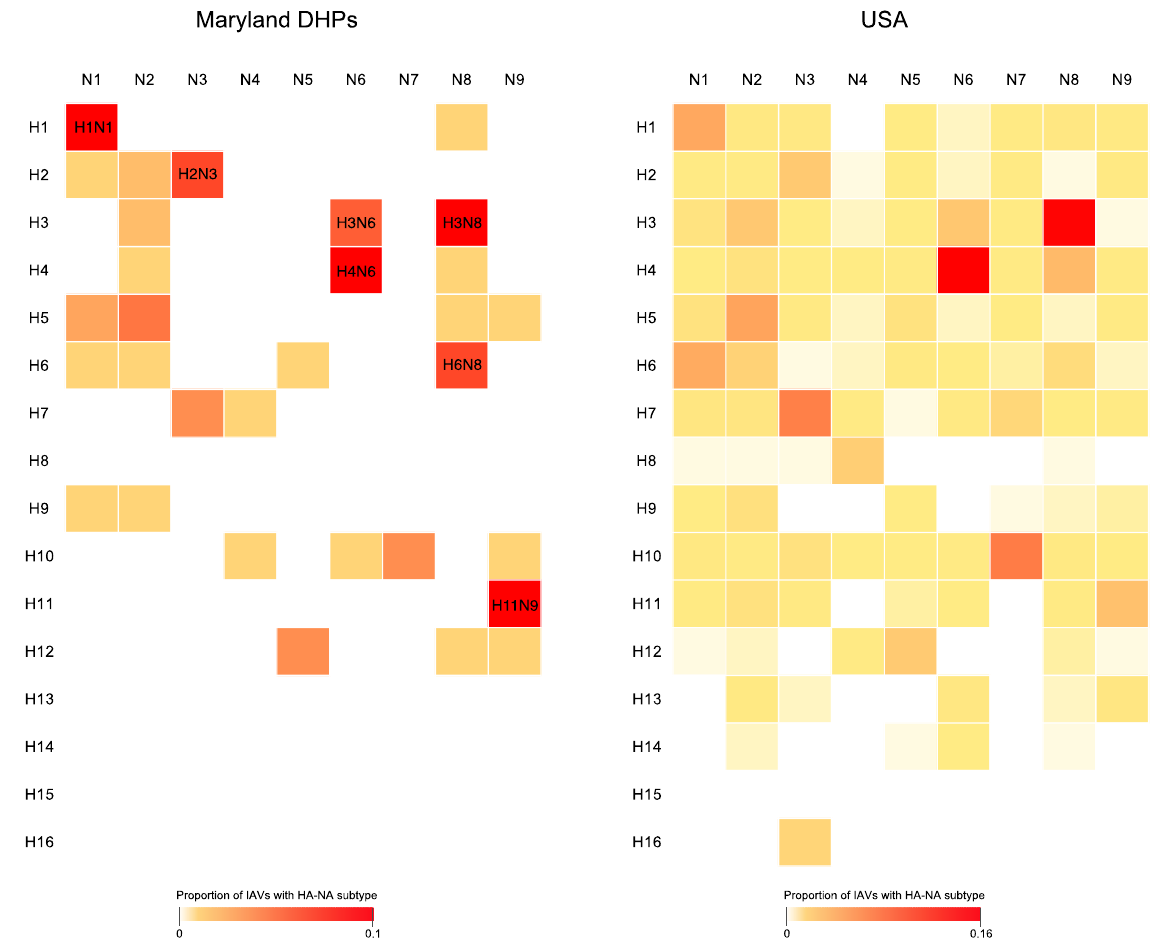
Figure 2. IAV subtypes in Maryland duck hunting preserves. The proportion of IAVs with different subtype combinations of the surface antigens HA and NA is depicted in heatmaps constructed for the DHPs (white = 0; red = 10%) and entire USA, excluding viruses isolated in poultry (white = 0; red = 16%), summarized over the 11 years of the study.